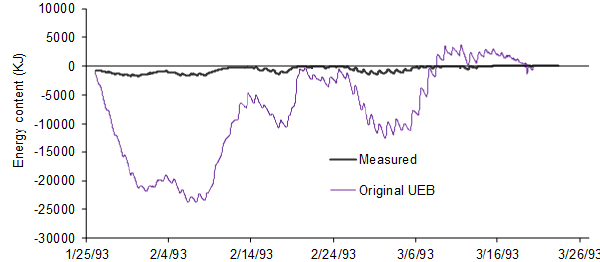
Figure 7. Comparisons between the measured and modeled internal energy of the snowpack at the USU drainage farm in the original model.